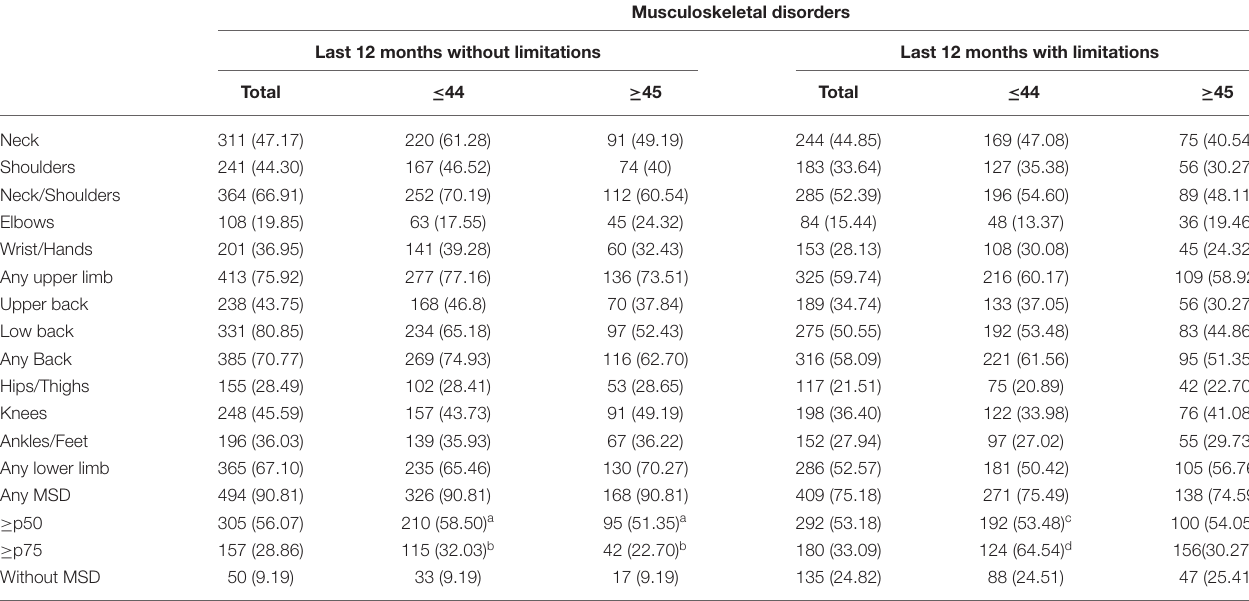
TABLE 3 | Prevalence of musculoskeletal disorders in the last 12 months with and without movement limitations according to age ranges.